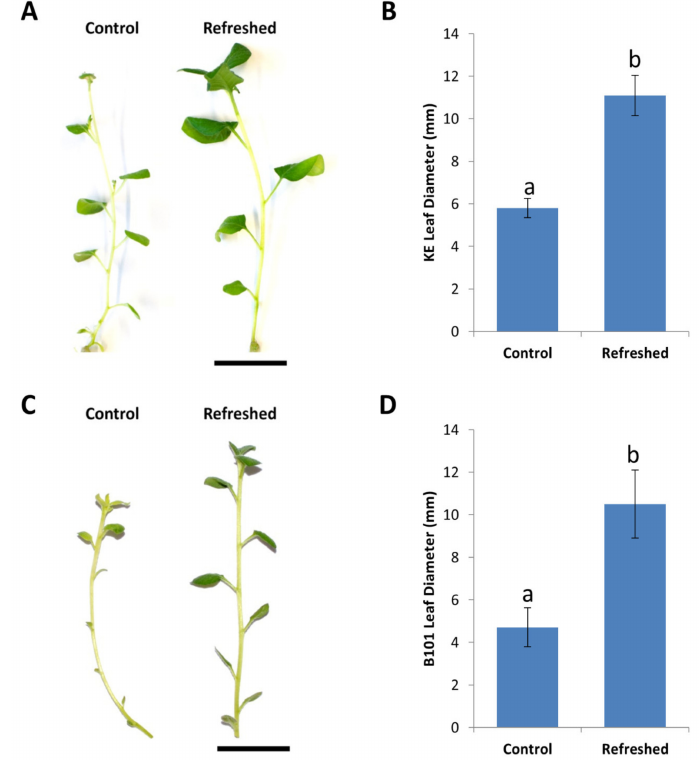
Figure 4. Improvement of plant vigor in Solanum tuberosum cv. King Edward and B101, following refreshment ex vitro on soil and in vitro via mini-tubers, respectively. ( A ) King Edward shoots showing improved shoot vigor following refreshment treatments ex vitro. ( B ) Increase in leaf diameter following refreshment treatment in King Edward (KE). ( C ) Refreshed B101 shoots displaying improved growth vigor following in vitro refreshment via mini-tubers. ( D ) B101 lines producing larger leaves following refreshment as compared to controls. Results are expressed as mean ± standard deviation. Twenty shoots were examined from each of the refreshed and control treatments and the experiment was repeated three times. Bars denoted by di ff erent lowercase letters a and b indicate a significant di ff erence at p < 0.05 through one-way ANOVA for each part of the figure